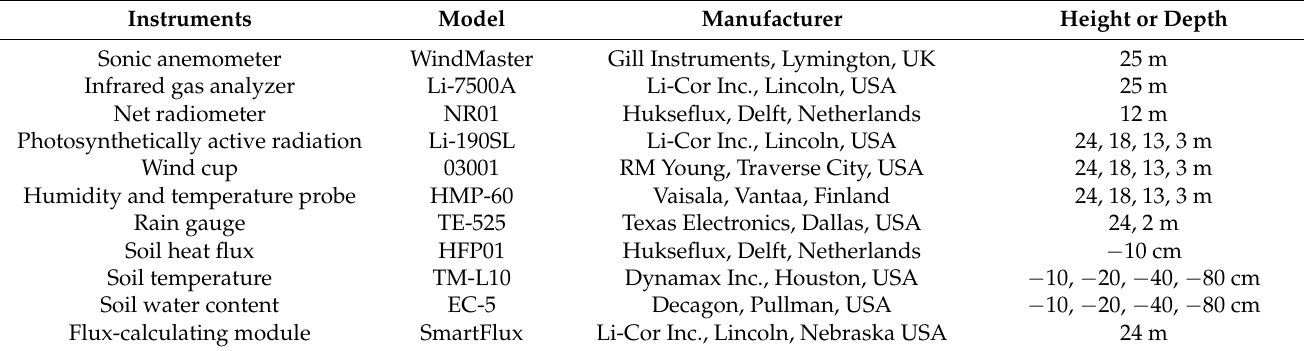
Table 1. Summary of instrumentation information.